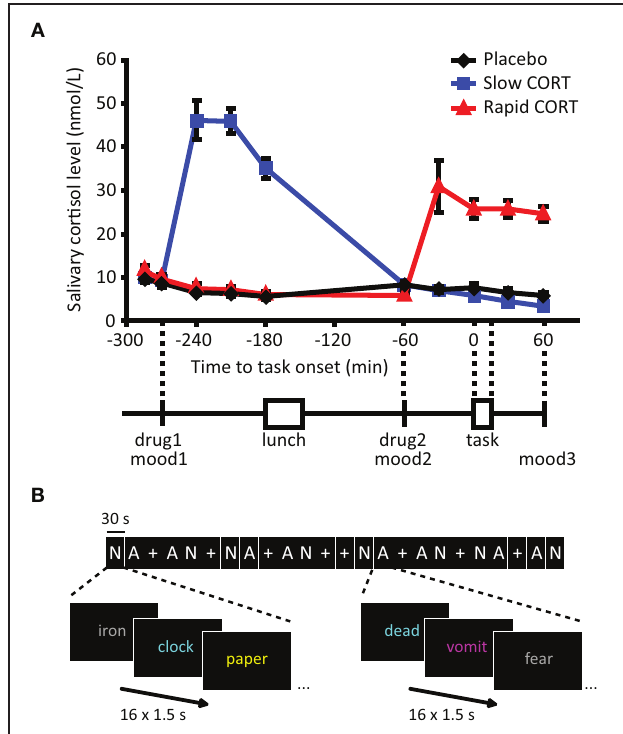
FIGURE 1 | Salivary cortisol data and experimental design. (A) Participants received two capsules (drug1 and drug2) containing either 10mg of hydrocortisone (CORT) or placebo at different time points before the emotional distraction task. Hydrocortisone intake significantly elevated salivary cortisol levels in both hydrocortisone administration groups to levels observed during moderate-to-severe stress (Morgan et al., 2000). (B) The emotional distraction task consisted of 30s-blocks of neutral (N) or aversive (A) words or fixation ( + ). Participants were requested to button press as fast as possible for the color in which the presented words were displayed. Mood: POMS questionnaire (Reddon et al., 1985; Wald and Mellenbergh, 1990; de Groot, 1992). Error bars represent S.E.M. N.B. In reality Dutch words were used, the words in Figure 1B only serve an illustrative